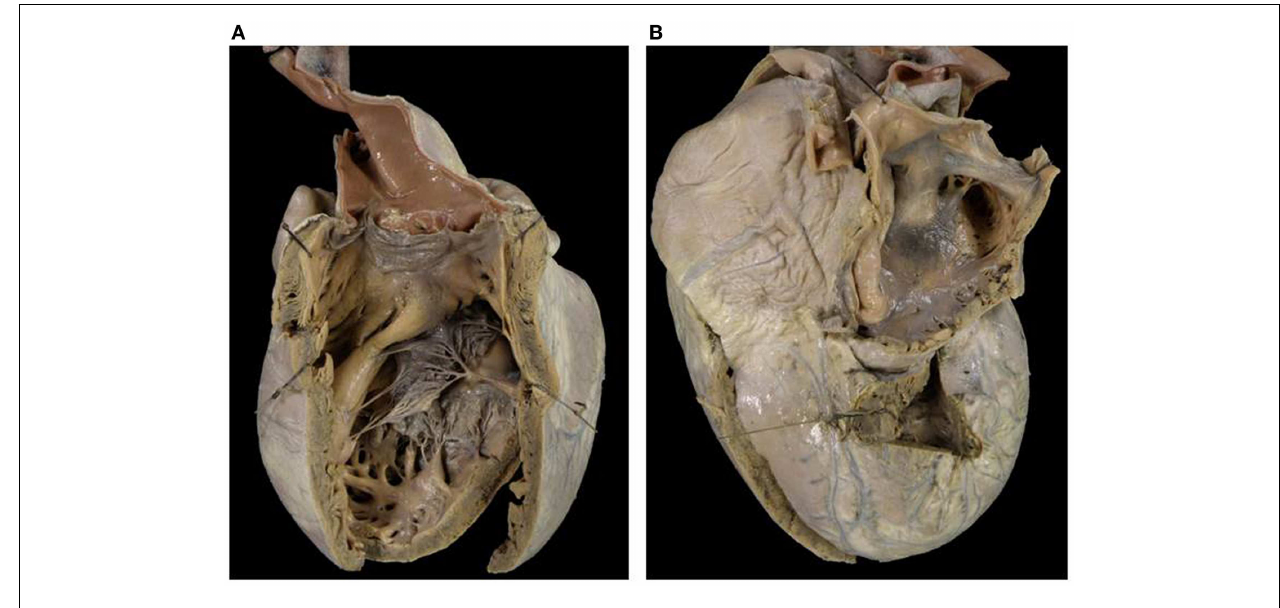
pulmonary valve is atretic (single aortic outlet). (B) At the floor of the right atrium there is no orifice.The underlying ventricular chamber is hypoplastic, posterior, right-sided and of left ventricular morphology ( L -loop).